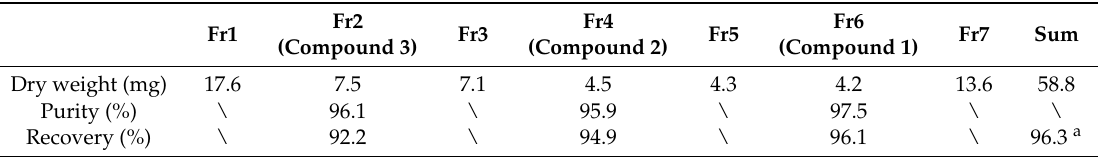
Table 1. Weights of fractions, purities and recoveries of the target compounds, and the total mass recovery after the HSCCC separation.